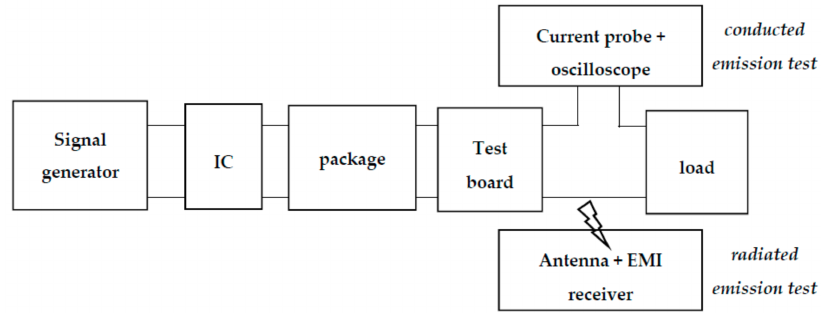
Figure 6. Schematics of the setup blocks for conducted and radiated emission